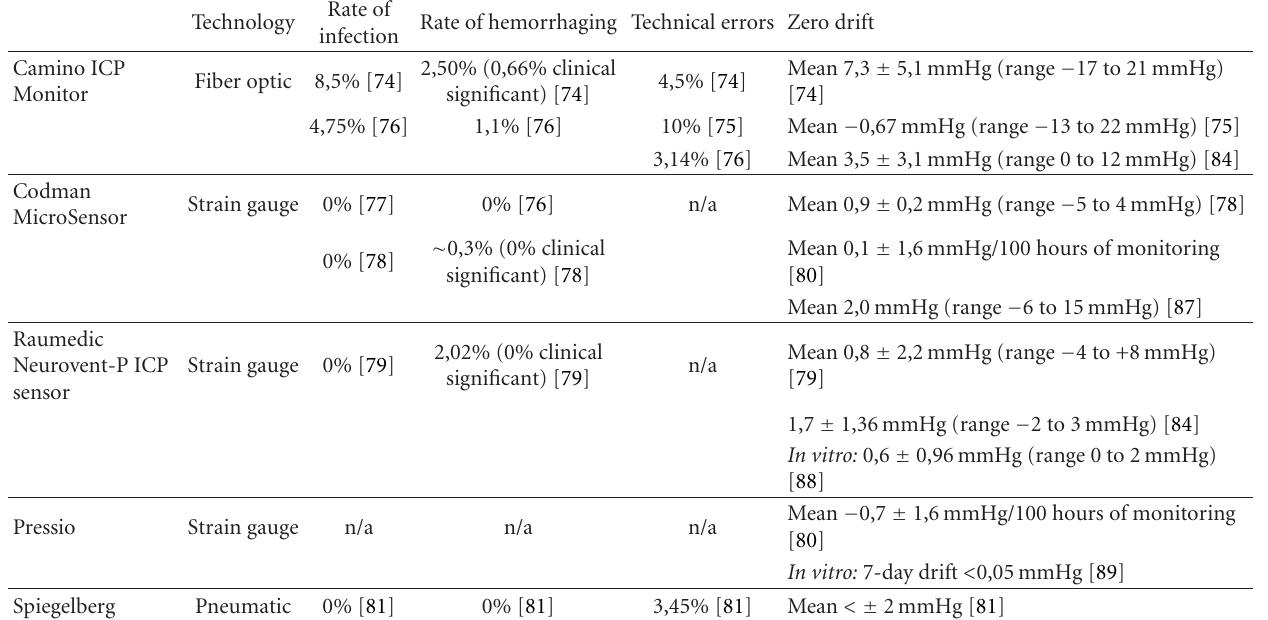
Table 2: Comparison of microtransducer ICP monitoring